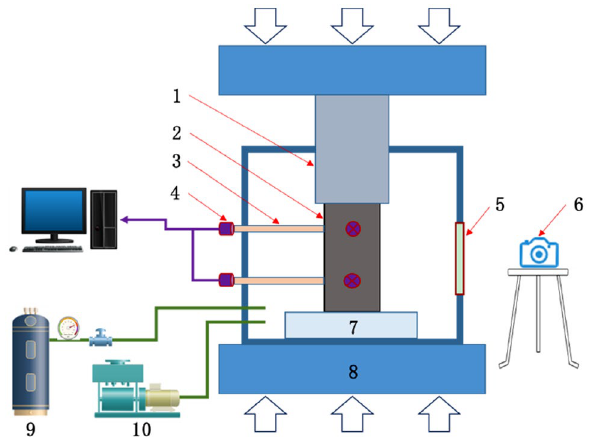
Figure 1. Diagrammatic sketch of experimental system for gas-bearing coal loading and AE monitoring. 1— Loading shaft; 2—coal specimen; 3—waveguide rod; 4—ae sensor; 5—visible window; 6—camera; 7—heel block for loading; 8—loading platform; 9—gas cylinder; 10—vacuum